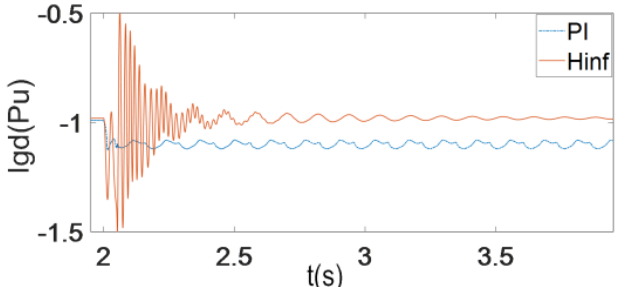
Figure 40. The influence of k ipll on i gd